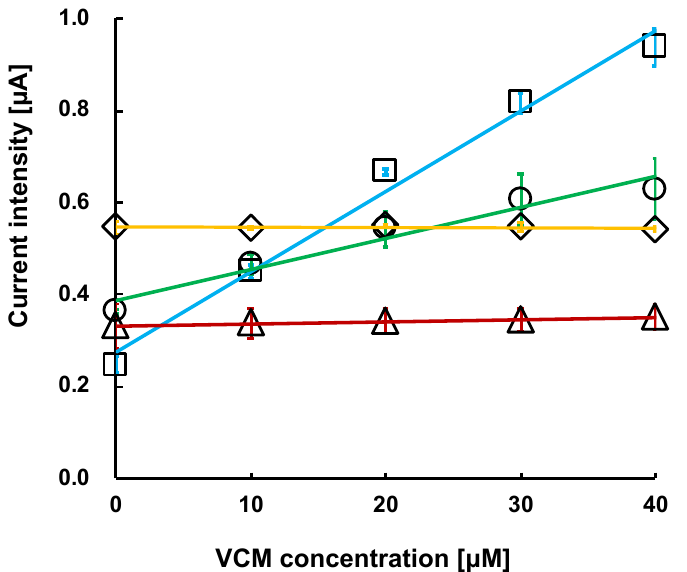
Figure 4. Relationship between VCM concentration and current intensity at 0.80 V vs. Ag/AgCl. ACPF (blue square), FMMA (yellow diamond), or VF (green circle) was used for the MIP synthesis. MIP electrode without ferrocenyl monomer (red triangle). Table 1. Sensitivity to VCM or TEIC at each electrode.